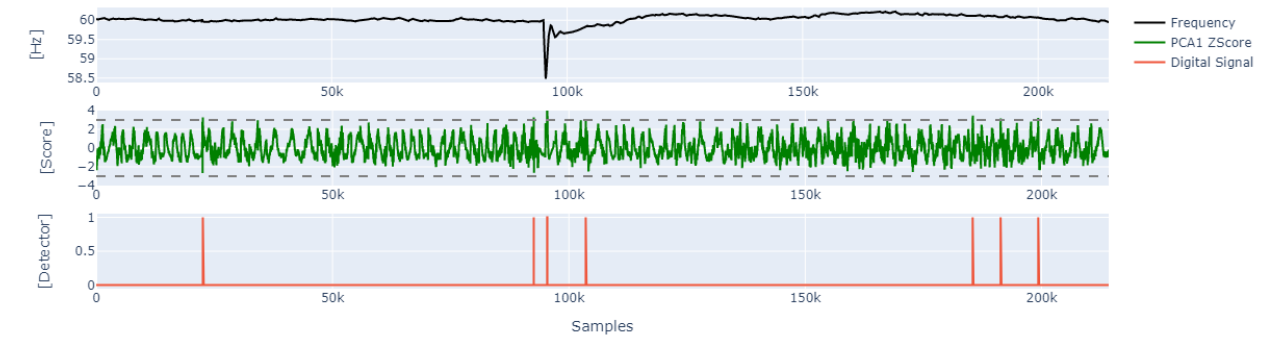
Figure 9. Event 1: detector event of PMU Cascavel (located at Parana State).